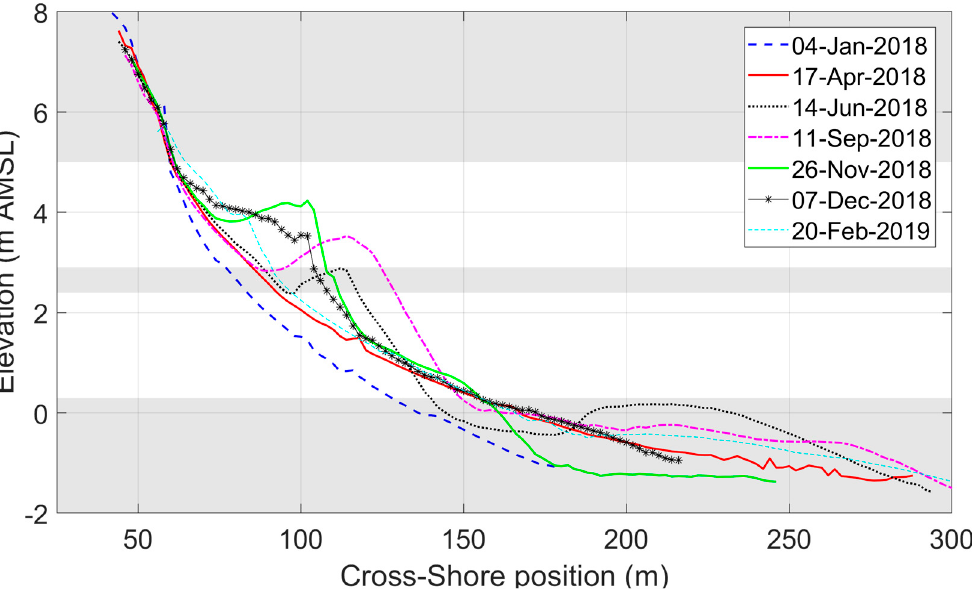
Figure 3. Superimposed beach profiles at a given transect covering over an entire year illustrating typical seasonal morphological changes at Truc Vert beach.